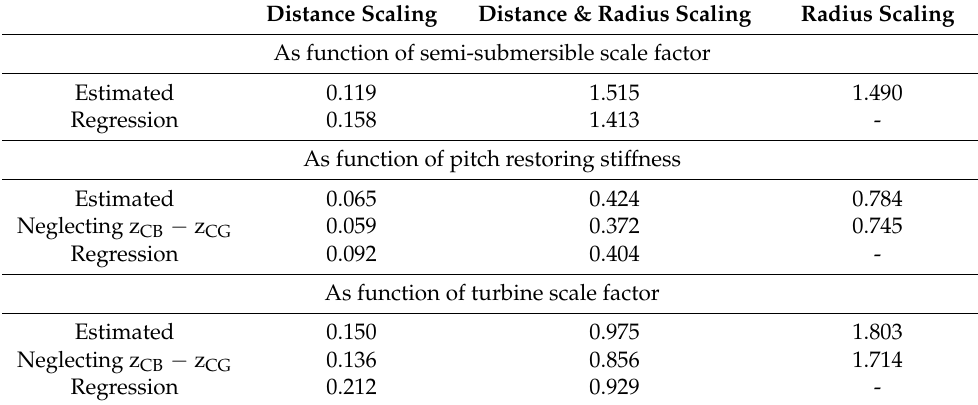
Table 4. Metal mass scaling